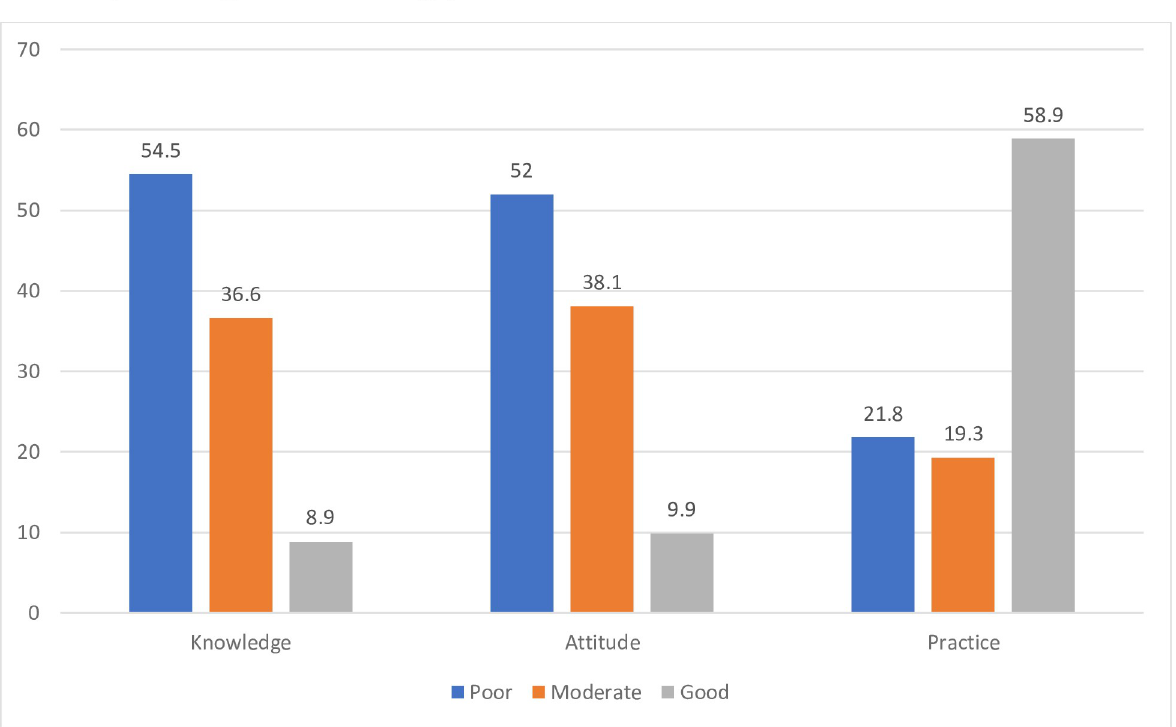
Fig 1. Knowledge, attitude, and practice of caregivers on neonatal jaundice.